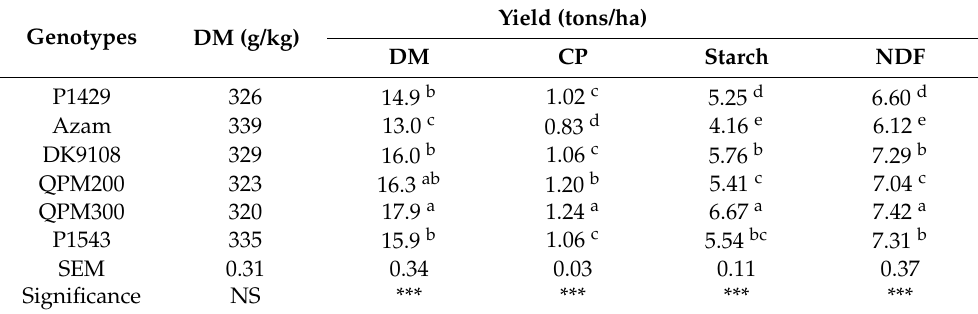
Table 2. Dry matter and nutrients yield of spring maize genotypes.